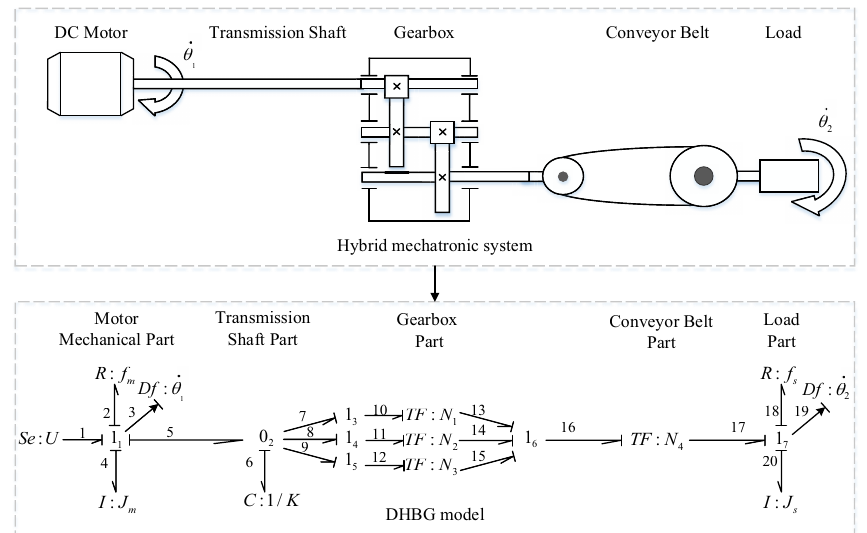
Figure 1. DHBG model of the hybrid mechatronic